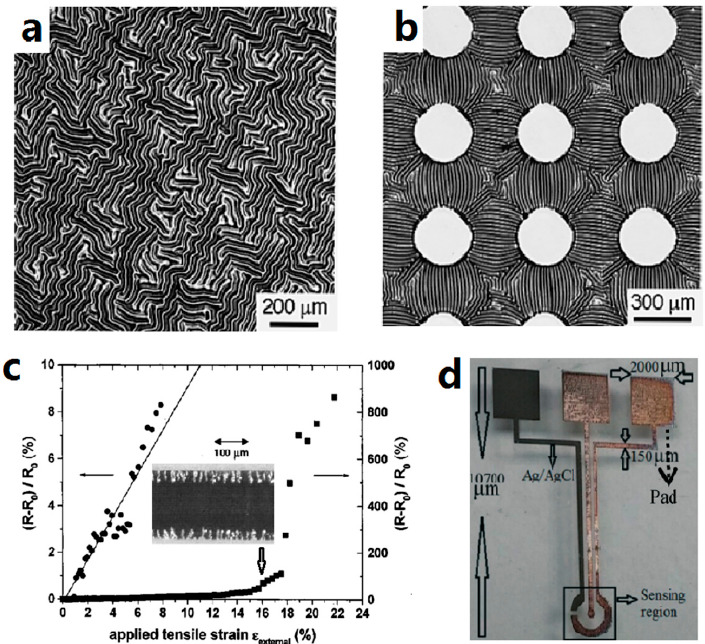
Figure 2. ( a ) Disordered buckling of Au film on flat, unconstraint PDMS (polydimethylsiloxane); ( b ) Ordered buckling of Au film on PDMS with flat circles (150 μ m in radius) elevated by 10–20 μ m; ( a , b ) are reprinted by permission from Macmillan Publishers Ltd.: Nature [1], Copyright 1998; ( c ) Normalized change in resistance of the Au stripe on PDMS under tensile strain. The left curve represents the linear behavior when the strain is below 8%. The inset is a photograph of the stripe stretched to 16.4%. Adapted from [12], with permission of AIP Publishing; ( d ) Ink-jet-printed Ag three-electrode electrochemical sensor. Reproduced from [25] with permission of The Royal Society of Chemistry.